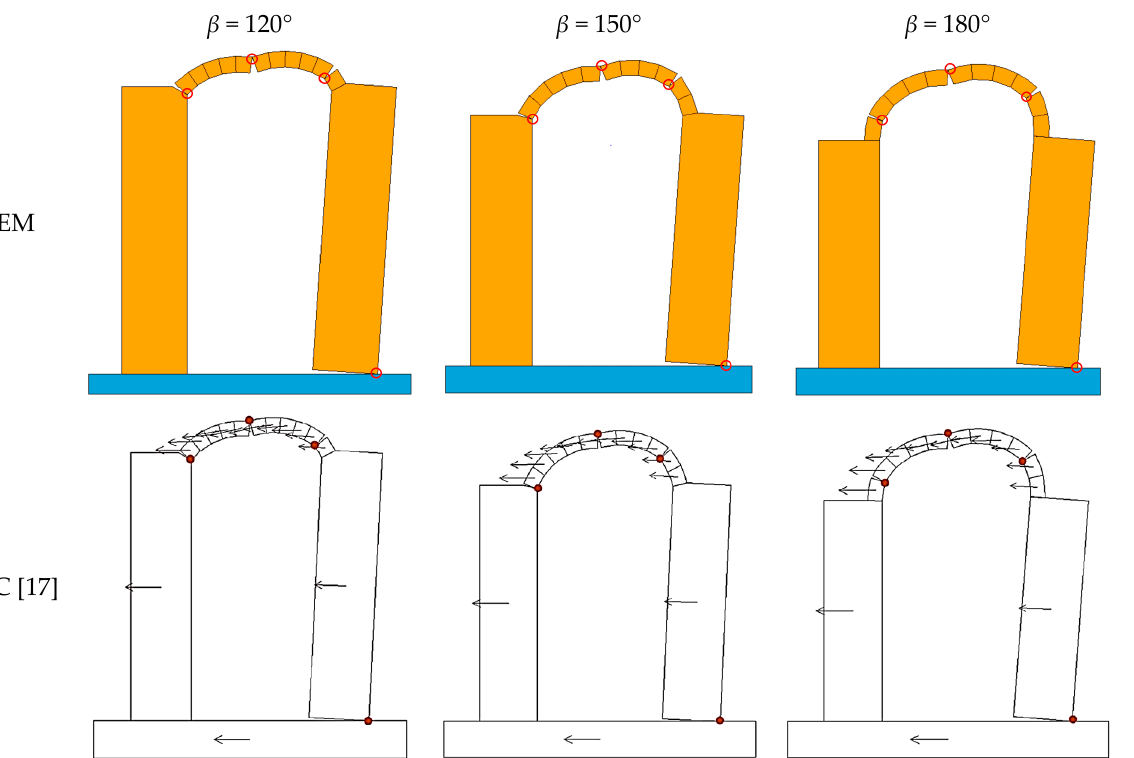
Figure 11. Failure modes of buttressed circular masonry arches.